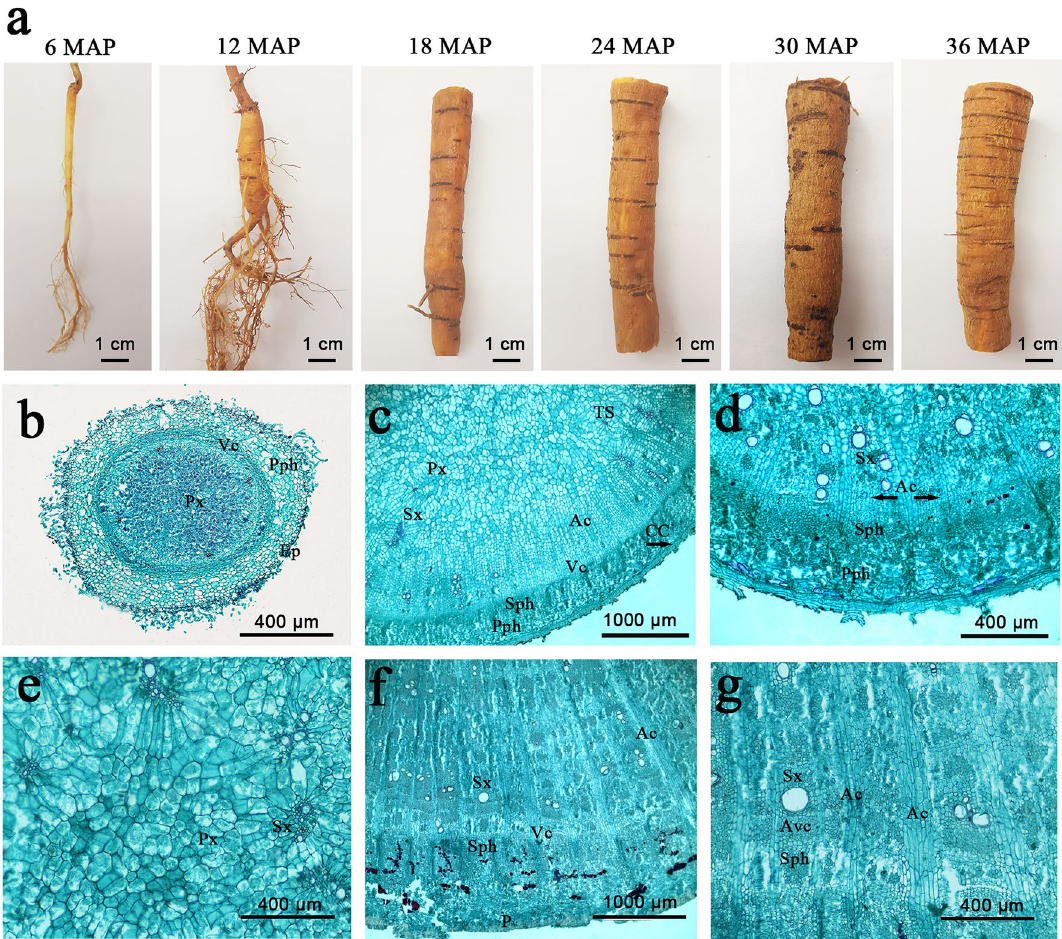
Figure 2. Morphological and anatomical features of C. speciosa roots at different developmental ages. ( a ) Root morphology. ( b ) Transverse section of root at 6 MAG. ( c ) Transverse section of root at 12 MAG. ( d , e ) Transverse section of root at 18 MAG. ( f , g ) Transverse section of root at 24 MAG. Ac anomalous cambium, Avc accessory cambium, CC cork cambium, Ep epidermis, P periderm, Pph primary phloem, Px primary xylem,